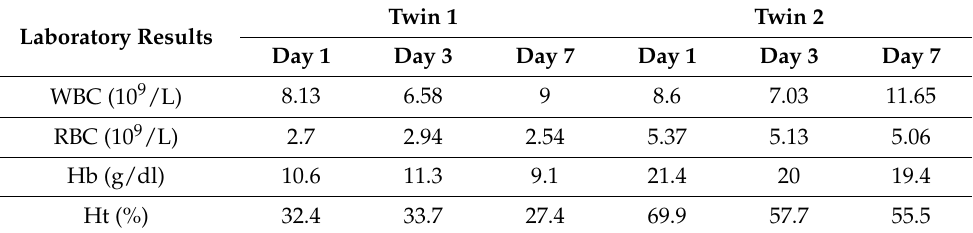
Table 1. Results of complete blood count and differential and conventional hematologic assays at day 1, day 3, and day 7. WBC: white blood cells; RBC: red blood cells; Hb: hemoglobin; Ht: hematocrit; PT: prothrombin time; aPTT: activated partial thromboplastin